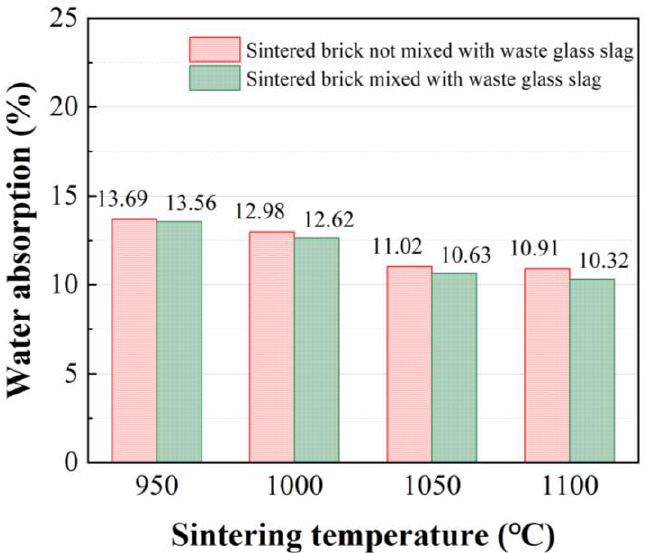
Figure 10. Effect of sintering temperature on water absorption of MGB sintered brick.